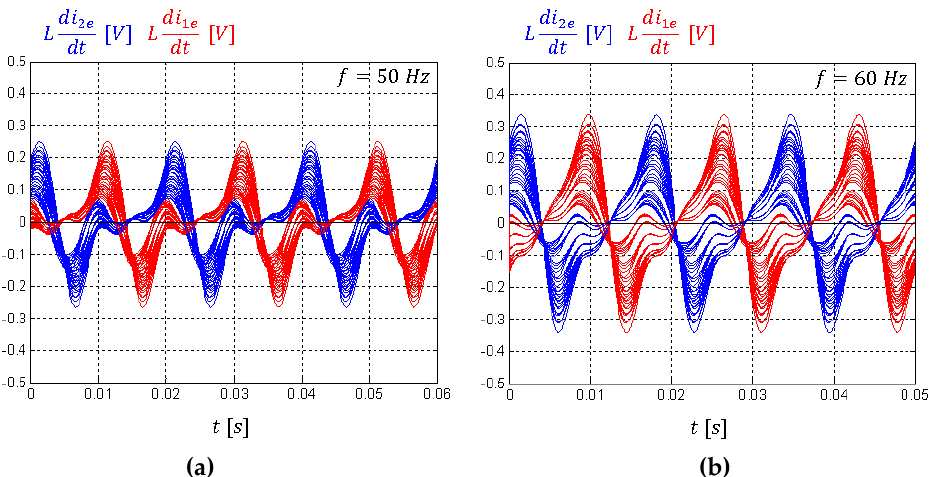
Figure 6. Evaluation of three cycles of the waveforms of the inductor voltages for the entire range of